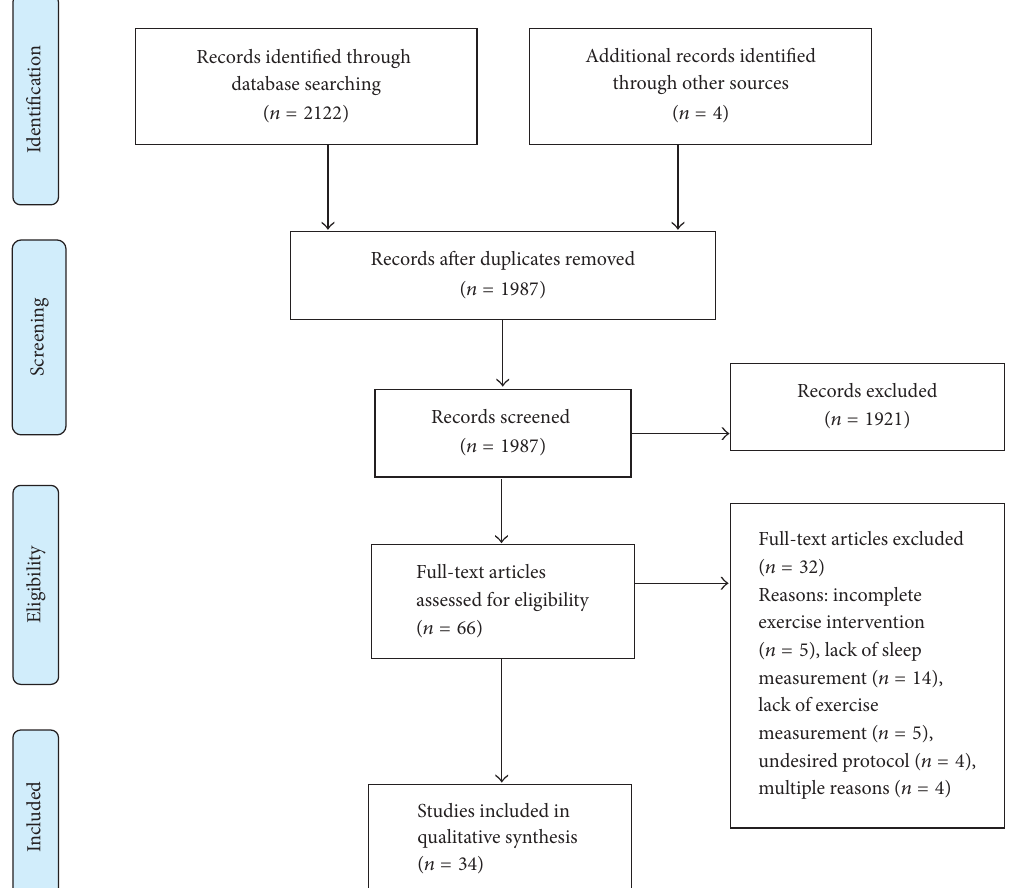
Figure 1: Preferred Reporting Items for Systematic Reviews and Meta-Analyses (PRISMA) flow